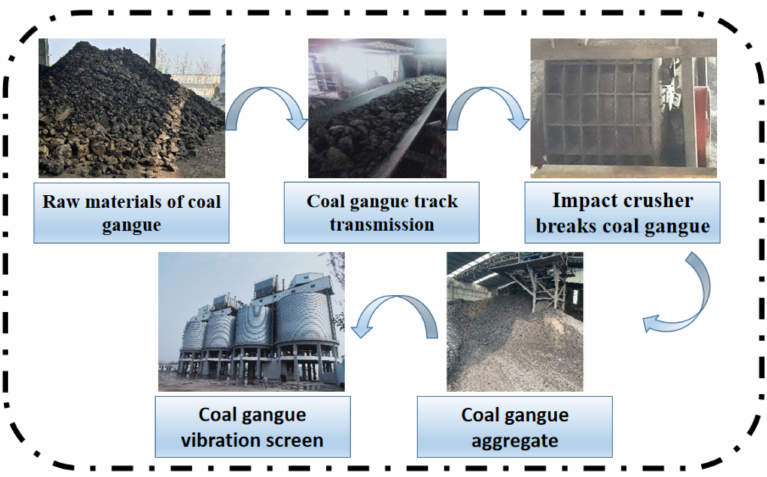
Figure 5. The breaking process for coal gangue with counterattack